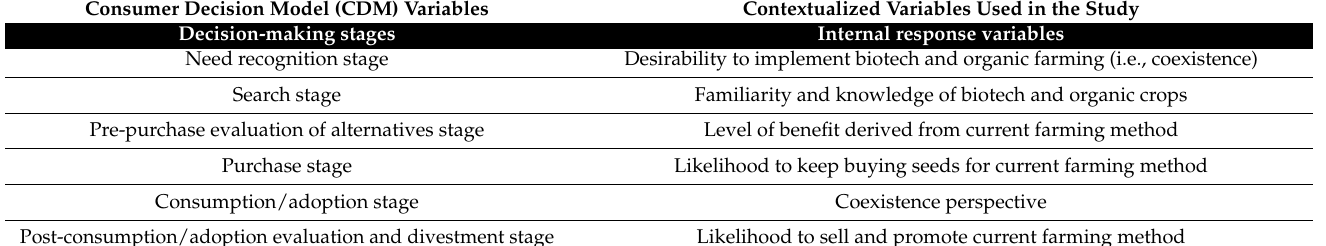
Table 1. Contextualized internal response variables and influential factors used in the study based on the Consumer Decision